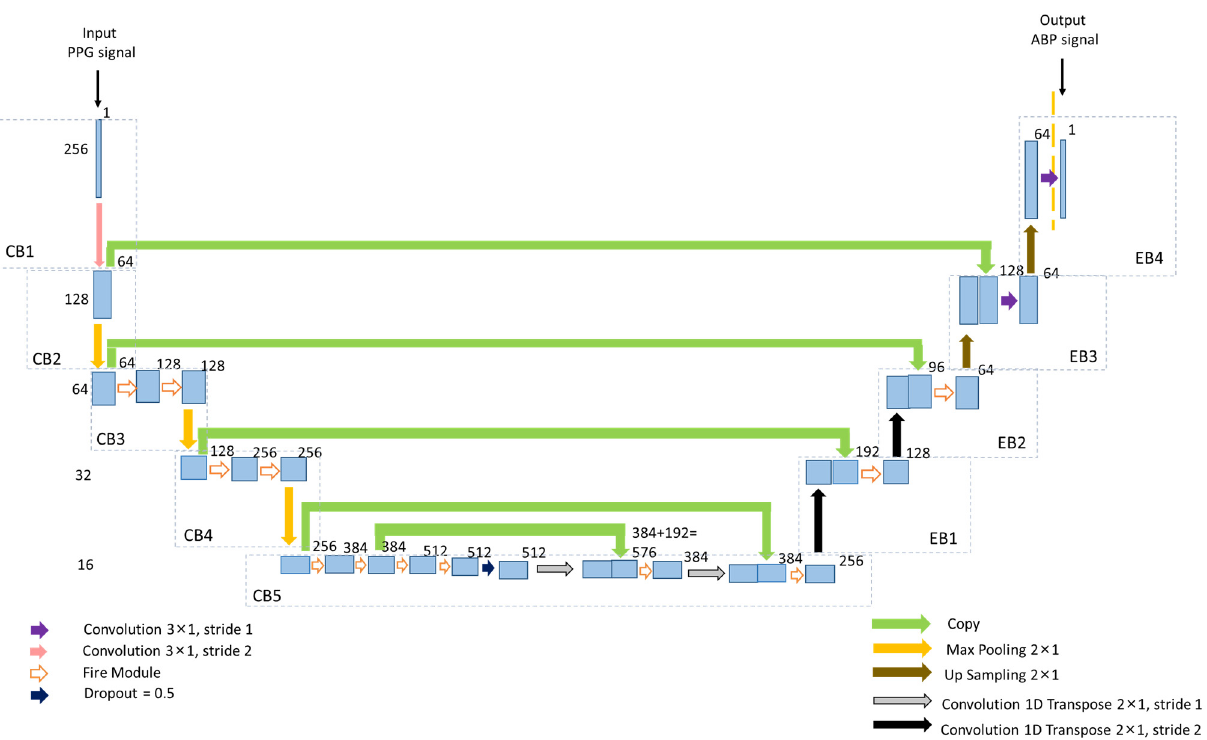
Figure 3. The proposed architecture of one-dimensional (1D) Squeeze U-net DL model.